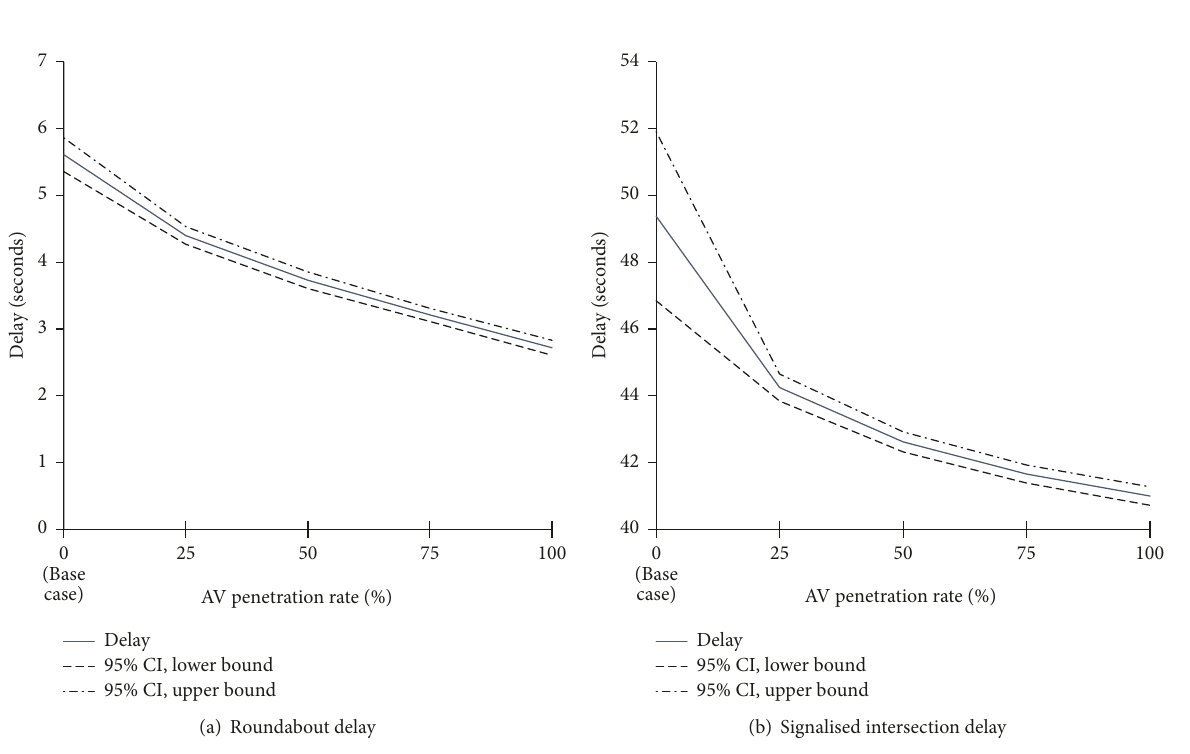
Figure 8: Average roundabout and intersection delay by penetration